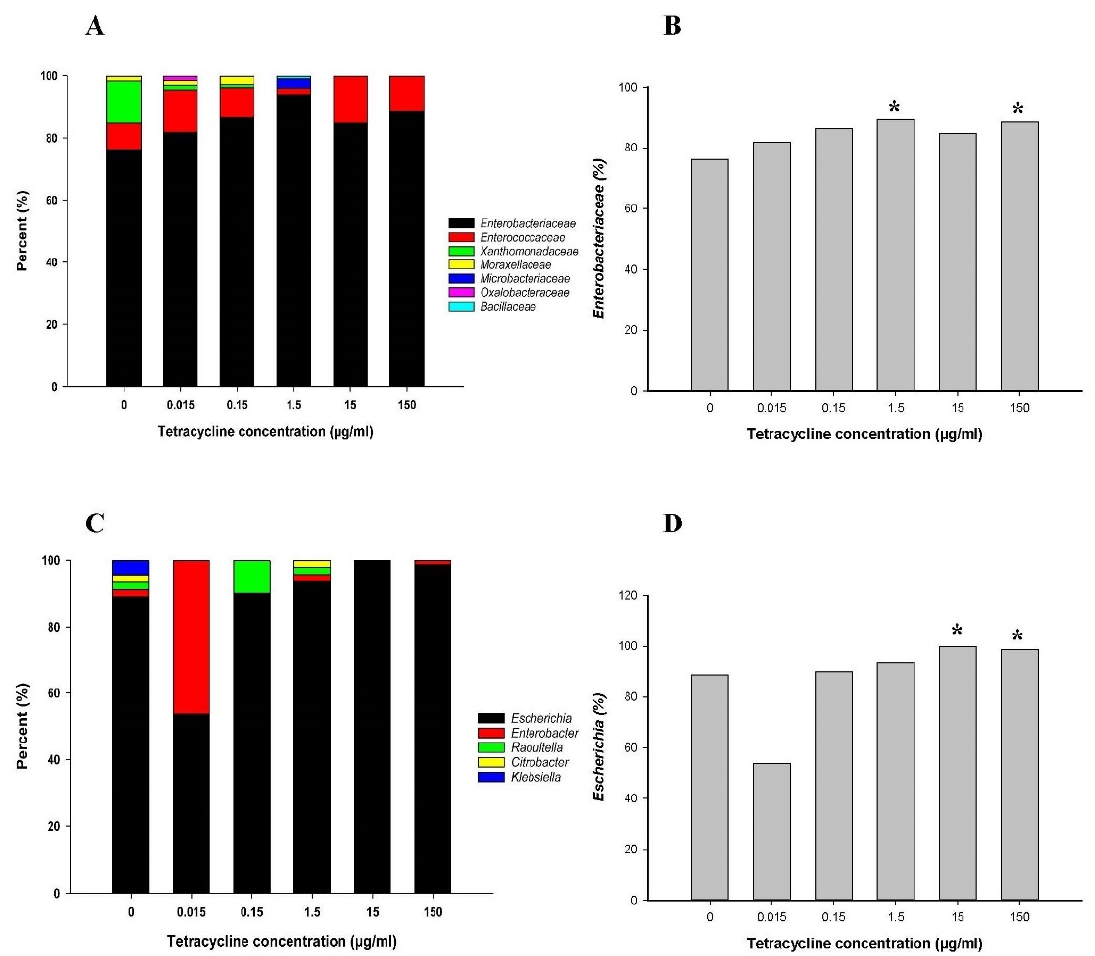
Figure 4. Changes in relative abundance of family ( A ), and genus ( B ), level and comparison of family Enterobacteriaceae ( C ), and genus Escherichia ( D ) in controls (no treatment) and tetracycline-treated samples after 7 days. * indicates statistically significant differences from control ( p < 0.05).